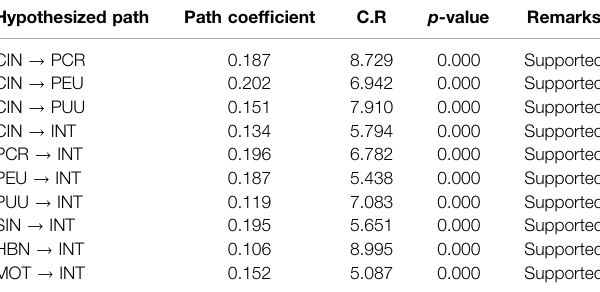
TABLE 8 | Results of path coef fi cients (direct